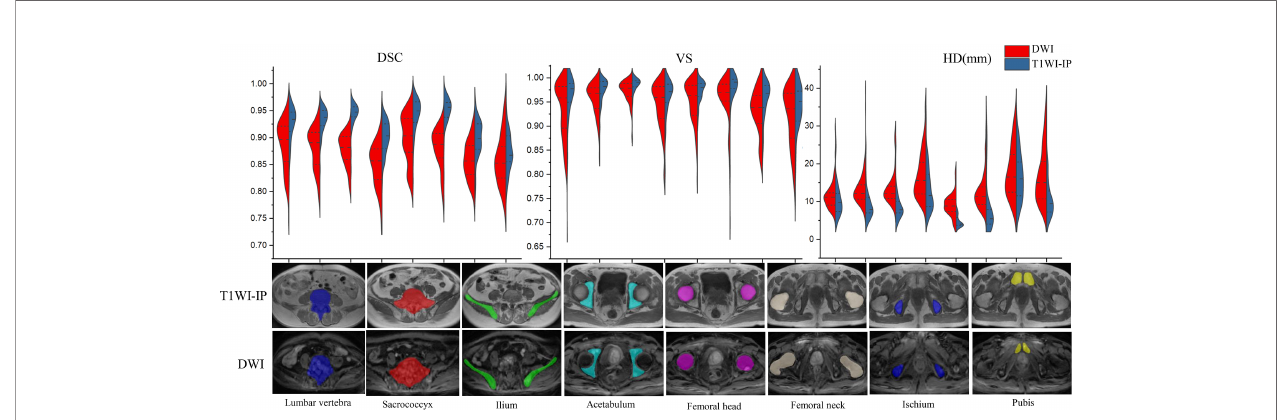
FIGURE 3 | Split violin plots of DSC, VS, and HD (mm) for pelvic bony structures segmentation. DSC, Dice similarity coef fi cient; HD, Hausdorff distance; T1WI-IP, T1W images obtained using the Dixon technique with in-phase; VS, volumetric similarity.